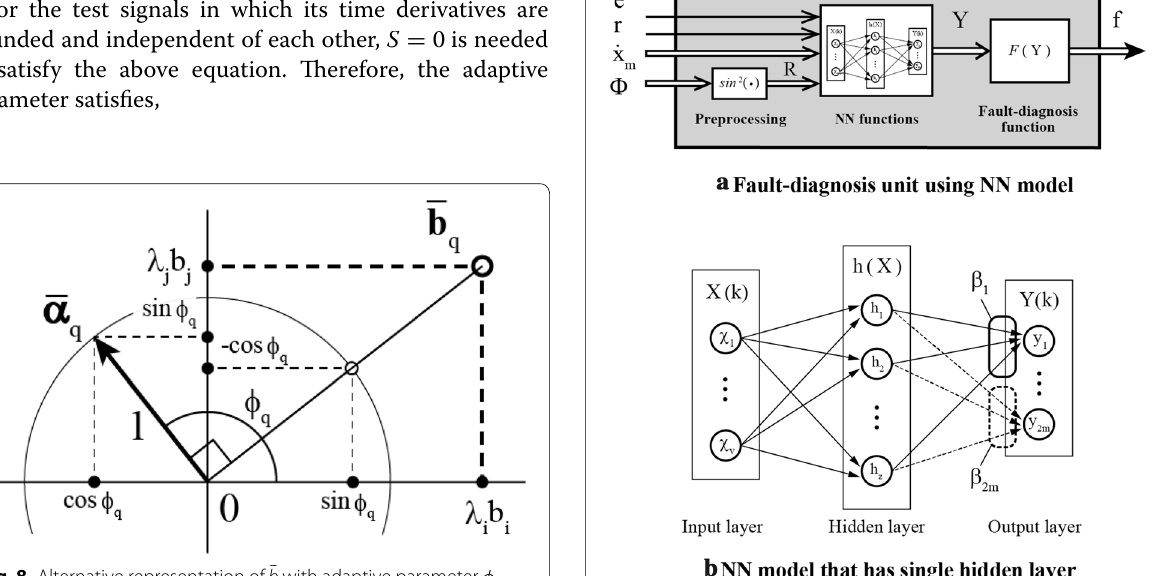
Fig. 8 Alternative representation of ¯ b with adaptive parameter φ based on the orthogonal condition ¯ b ⊥¯ α